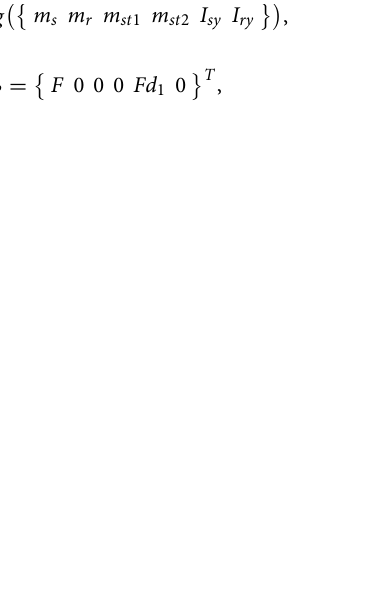
Table 1. Identified system